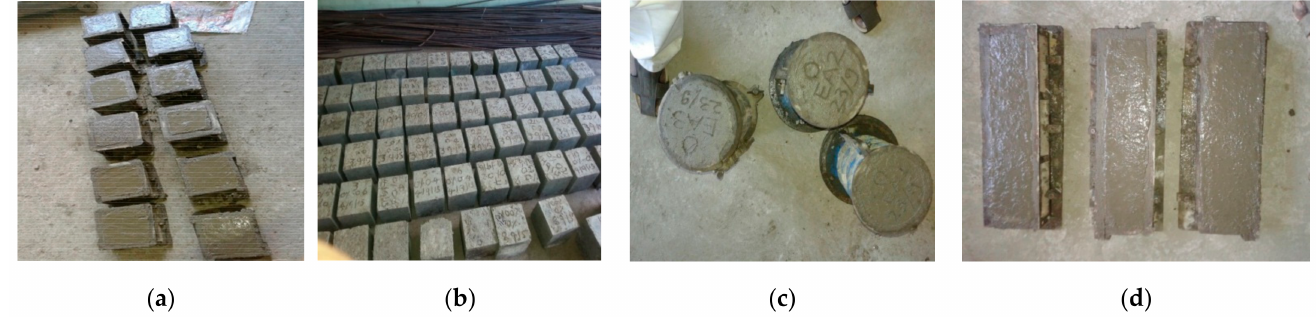
Figure 3. Cast of specimens processed: ( a ) cube samples, ( b ) samples dismantled from the molds, ( c ) cylinder samples, and ( d ) prism samples.